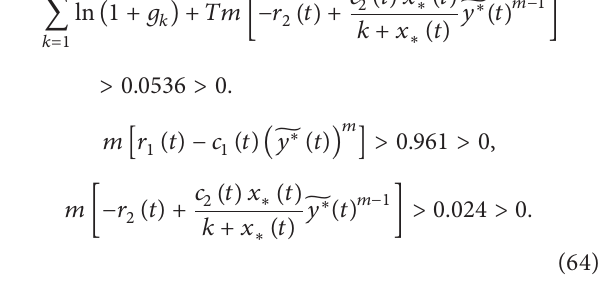
Figure 4: (a) Bifurcation of 𝑔 𝑘 when ℎ 𝑘 is fixed at 0.4; (b)–(d) phase portraits. Table 4: The effects of 𝑔 𝑘 on the dynamical behavior of system